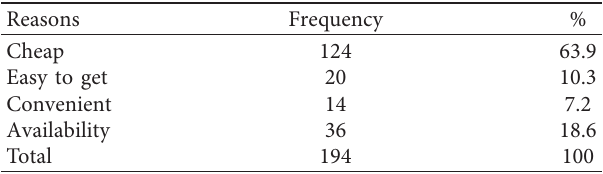
Table 4: Reason for fuel wood